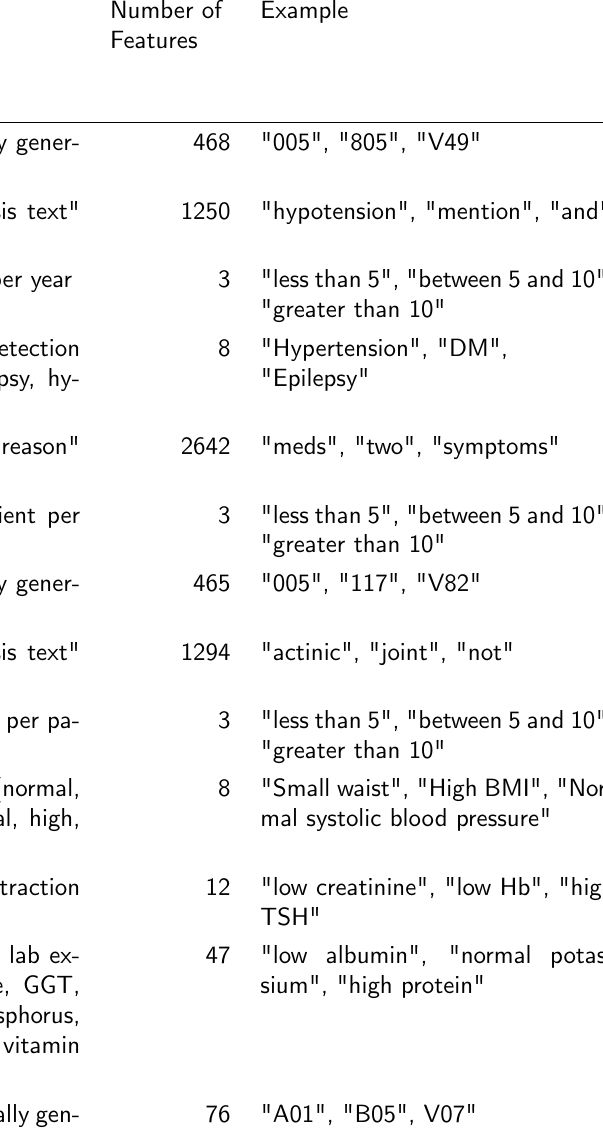
Table 3: Description of Features Extracted From CPCSSN Tables